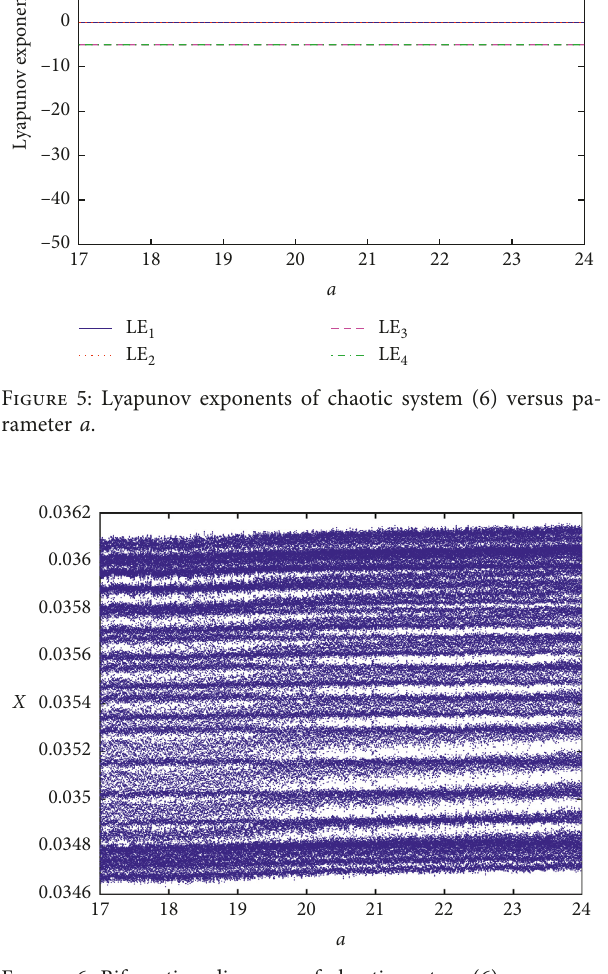
Figure 6: Bifurcation diagrams of chaotic system (6) versus pa- rameter a